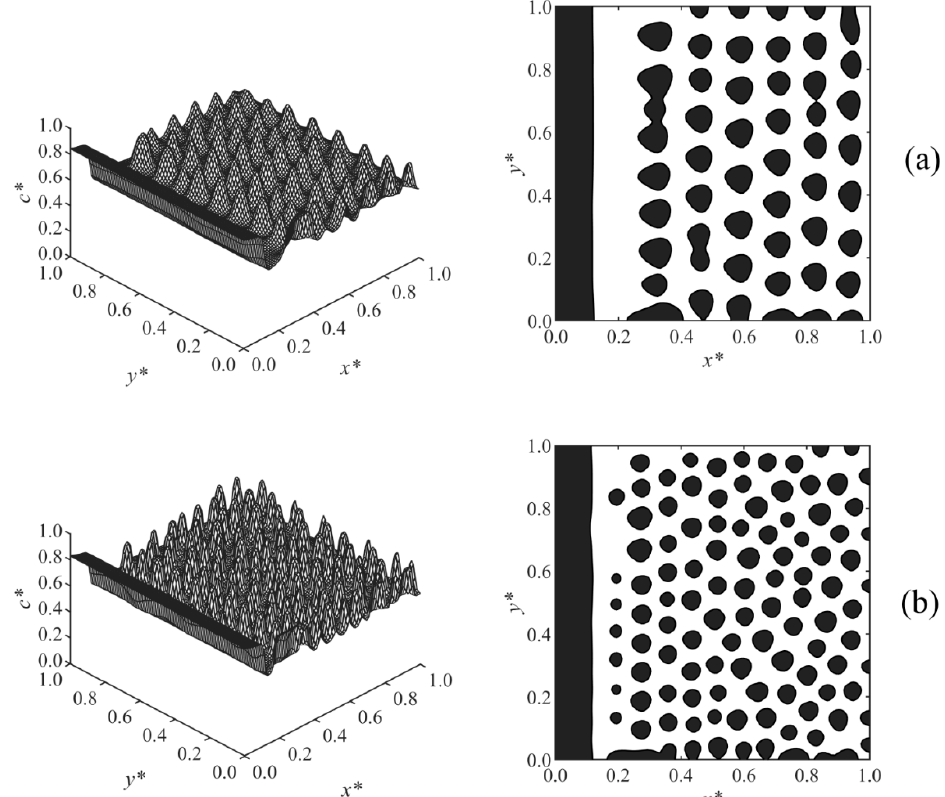
Figure 6. Spatial concentration distributions (first column) and phase-separated morphologies (second column) for Case 4 at the following dimensionless times and diffusion coefficients: ( a ) t * = 1.0025 × 10 − 4 , D = 1 × 10 6 , ( b ) t * = 9.85 × 10 − 5 , D = 3 × 10 6 .